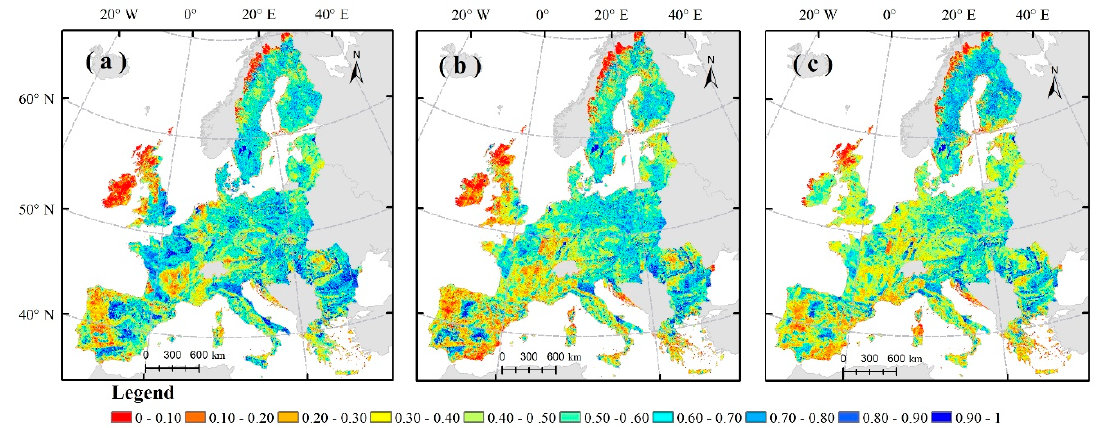
Figure 8. Spatial consistency of target classes between: ( a ) GlobeLand30-2010 and GLC_FCS30-2015, ( b ) GlobeLand30-2010 and FROM_GLC30-2015, ( c ) GLC_FCS30-2015 and FROM_GLC30-2015.